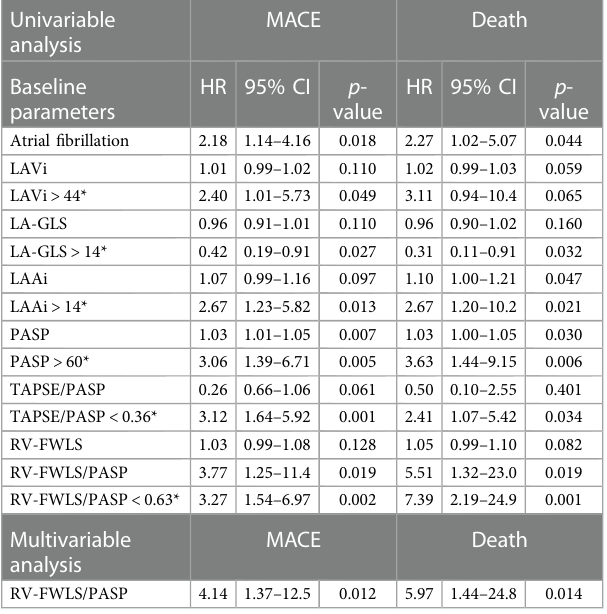
TABLE 6 Predictors of MACE and mortality (Cox regression analysis). Univariable